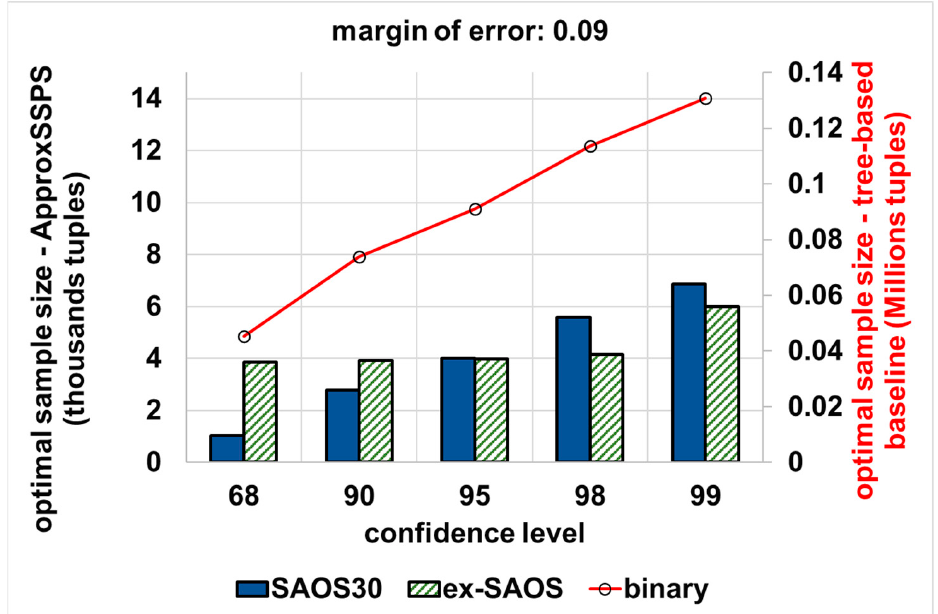
Figure 11. The optimal sample size that is required to achieve a more permissive accuracy target (an error bound that equals 0.09) for both systems (ApproxSSPS and the tree-based baseline): “computing the average ‘trip distance’ in NYC taxicabs mobility data”. ApproxSSPS with all geohash precisions and for all confidence levels achieves a significantly much lower optimal sample size as opposed to the baseline. It is a discernible pattern that all methods require a higher sample size as the confidence level increases.